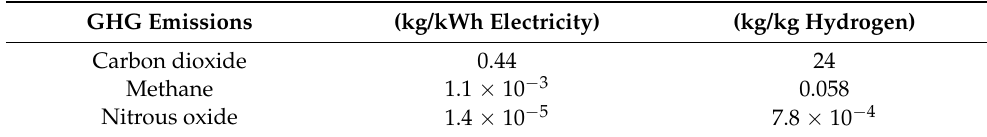
Table 3. Greenhouse gas (GHG) emissions of German grid mix, year 2018, and respective GHG emissions for hydrogen from